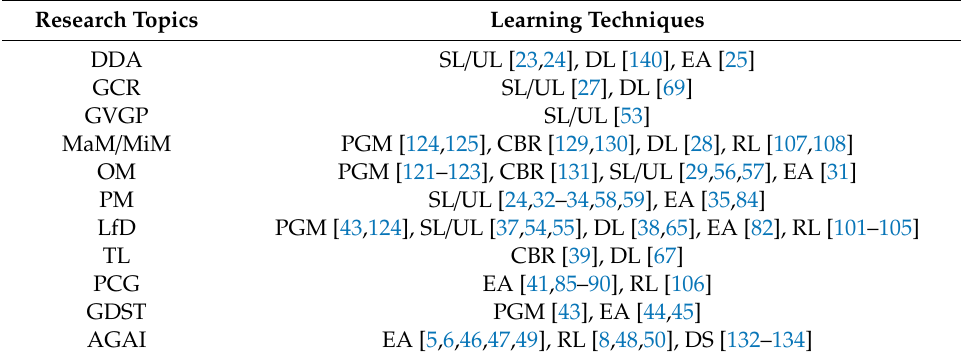
Table 2. Table presenting some of the most common game AI research topics together with examples of proposed implementations using the learning techniques discussed. To ease the readability of the table the acronyms of the research topics are repeated here. Dynamic Di ffi culty Adjustment (DDA), Game Content Recommendation (GCR), General Video Game Playing (GVGP), macromanagement (MaM), micromanagement (MiM), Opponent Modeling (OM), Player Modeling (PM), Learning from Demonstration (LfD), Transfer Learning (TL), Procedural Content Generation (PCG), Game Design Support Tools (GDST) and Adaptive Game AI